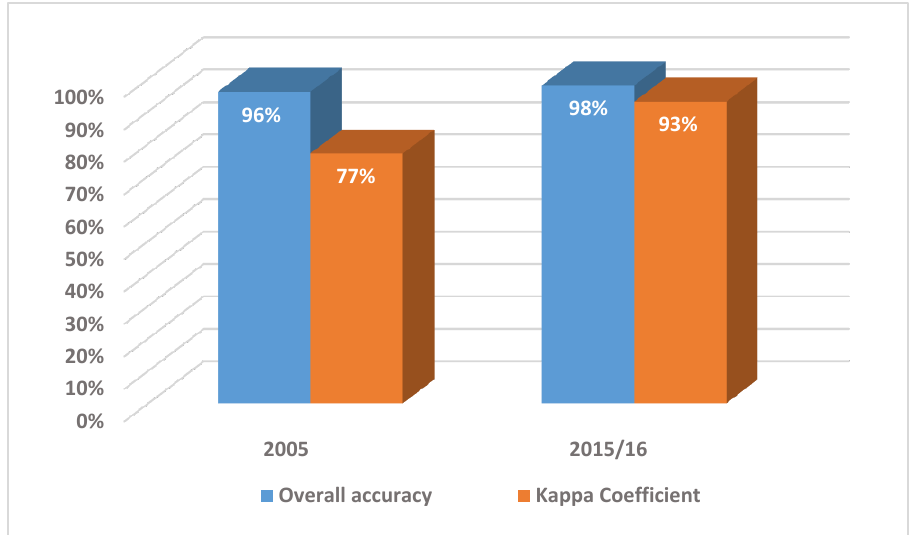
Figure 10. Accuracy assessment of tree extraction using the object-based convolutional neural network (OB-CNN) for 2005 and 2015/16.